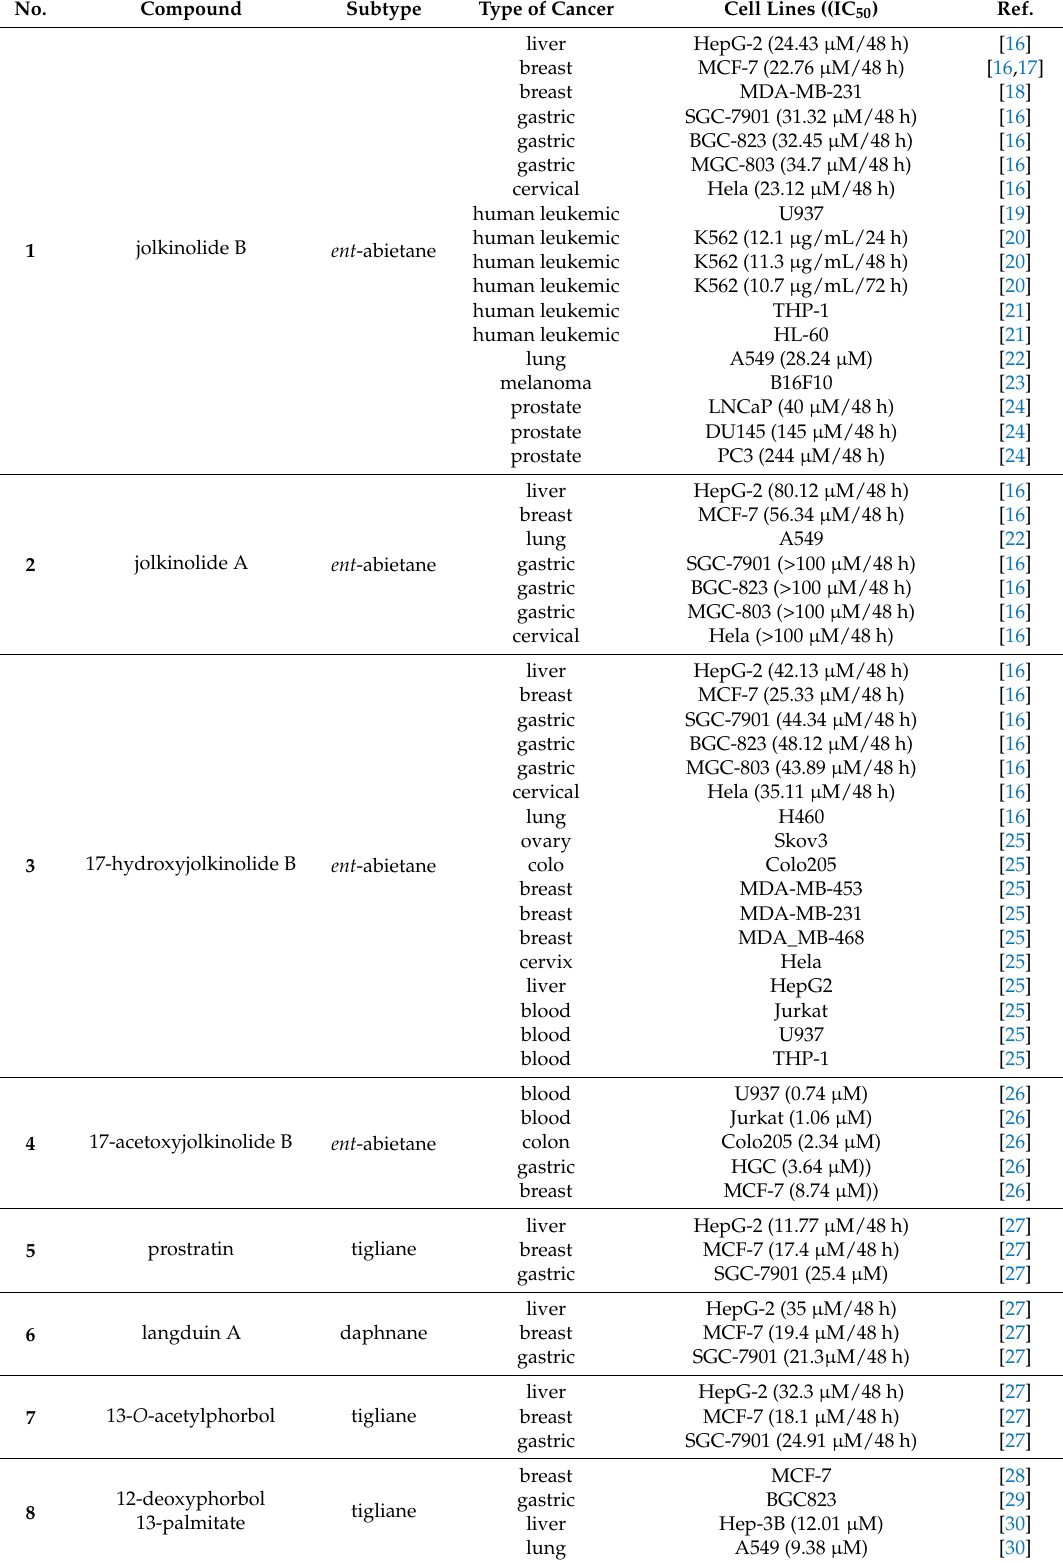
Table 1. Emerging cytotoxic diterpenoids in E. fischeriana in